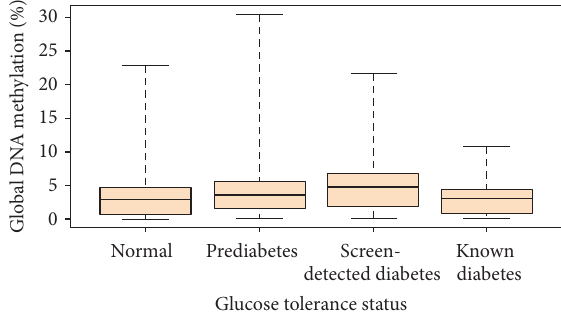
Figure 1: Boxplot showing the distribution of global DNA methy- lation across glucose tolerance status. Global DNA methylation was significantly higher in diabetic participants than in normotolerant participants ( 𝑝 = 0.0003 ), significantly higher in screen-detected diabetes than in known diabetes ( 𝑝 = 0.0188 ), and significantly higher in prediabetes than in normal glucose tolerance ( 𝑝 = 0.0328 ). But there was no difference in global DNA methylation between known diabetes and normal glucose tolerance ( 𝑝 > 0.999 ) and between known diabetes and prediabetes ( 𝑝 = 0.408 ); all 𝑝 values are adjusted for multiple comparisons. Median global DNA methylation (25th–75th percentiles): normal: 2.81 (0.68–4.62; 𝑁 = 284 ); prediabetes: 3.40 (1.53–5.45; 𝑁 = 120 );